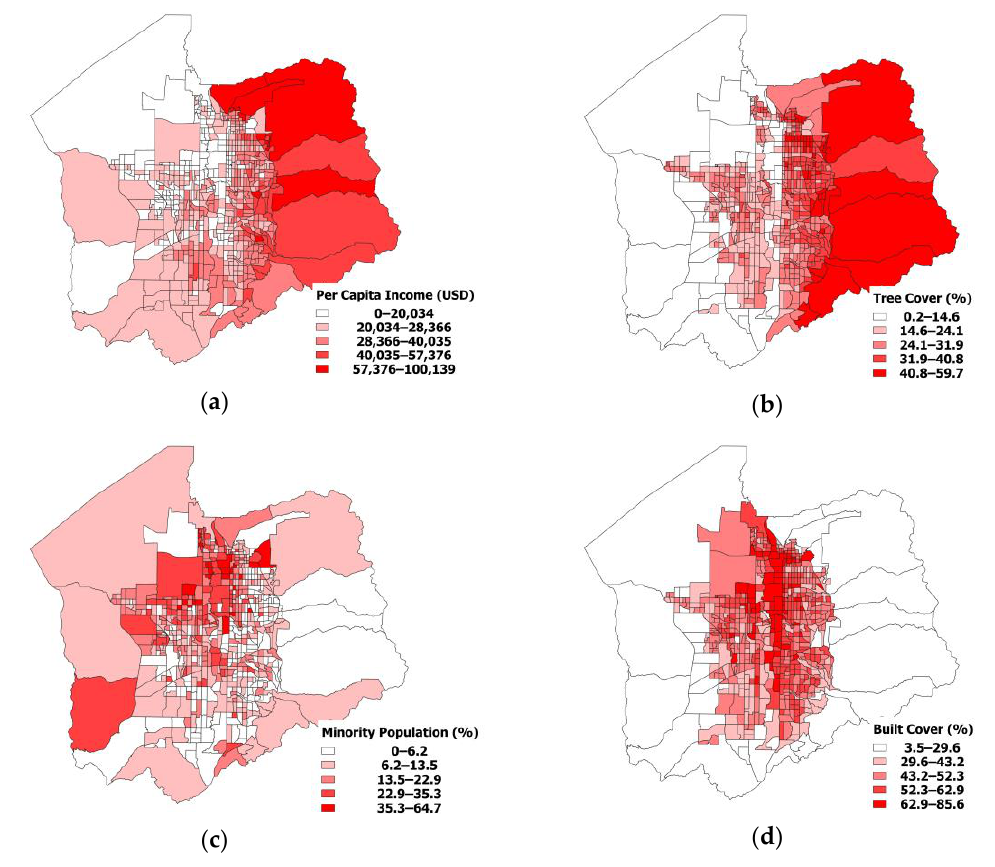
Figure 3. Spatial distribution of sociodemographic and land cover categories at the block group level: ( a ) Per capita income; ( b ) Tree cover; ( c ) Minority population; and ( d ) Built cover.